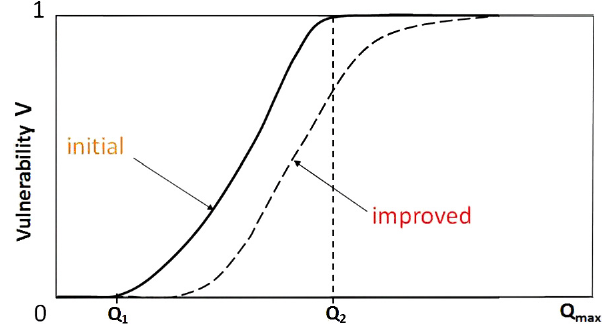
Figure 1. The vulnerability of a system (initial and improved) as a function of the magnitude of the